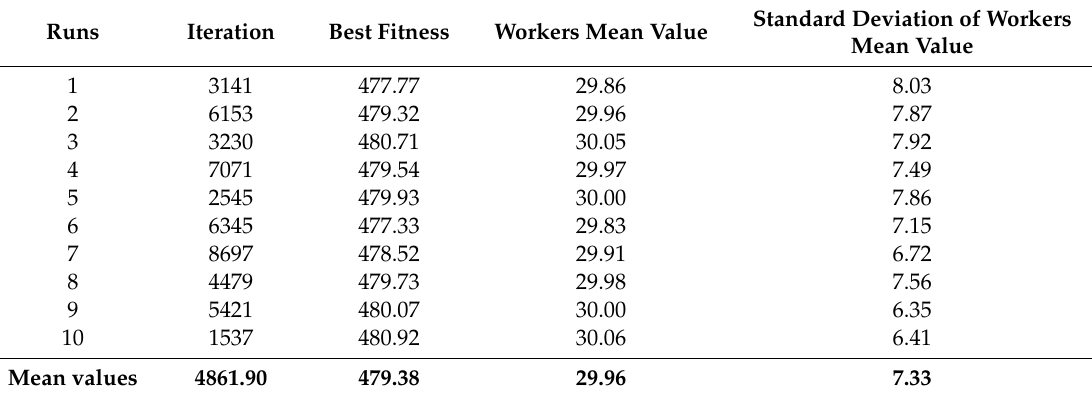
Table 6. Result of the RGAm